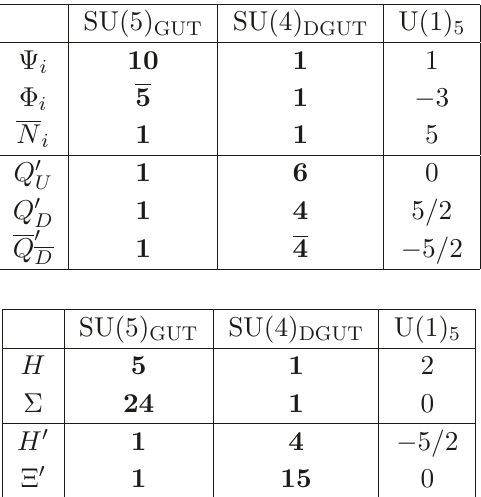
Table 2 . Charge assignment of fermions and scalars in the minimal SU(5) GUT model. The upper rows of the tables show the assignment in the SU(5) GUT sector while the lower rows show that in the SU(4) DGUT